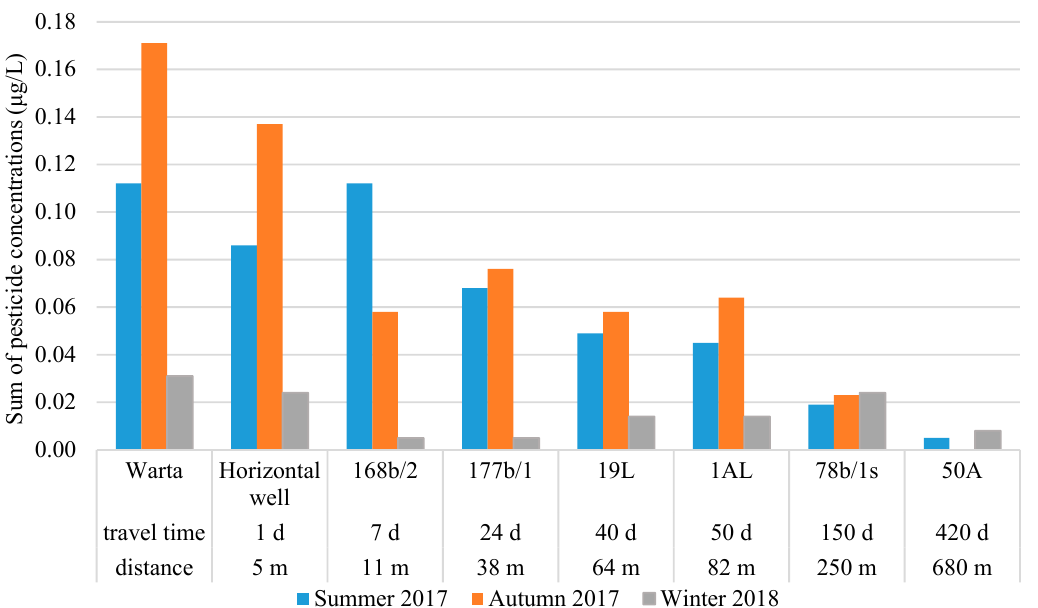
Figure 7. Changes in the detected micropollutant concentrations along the flow path.